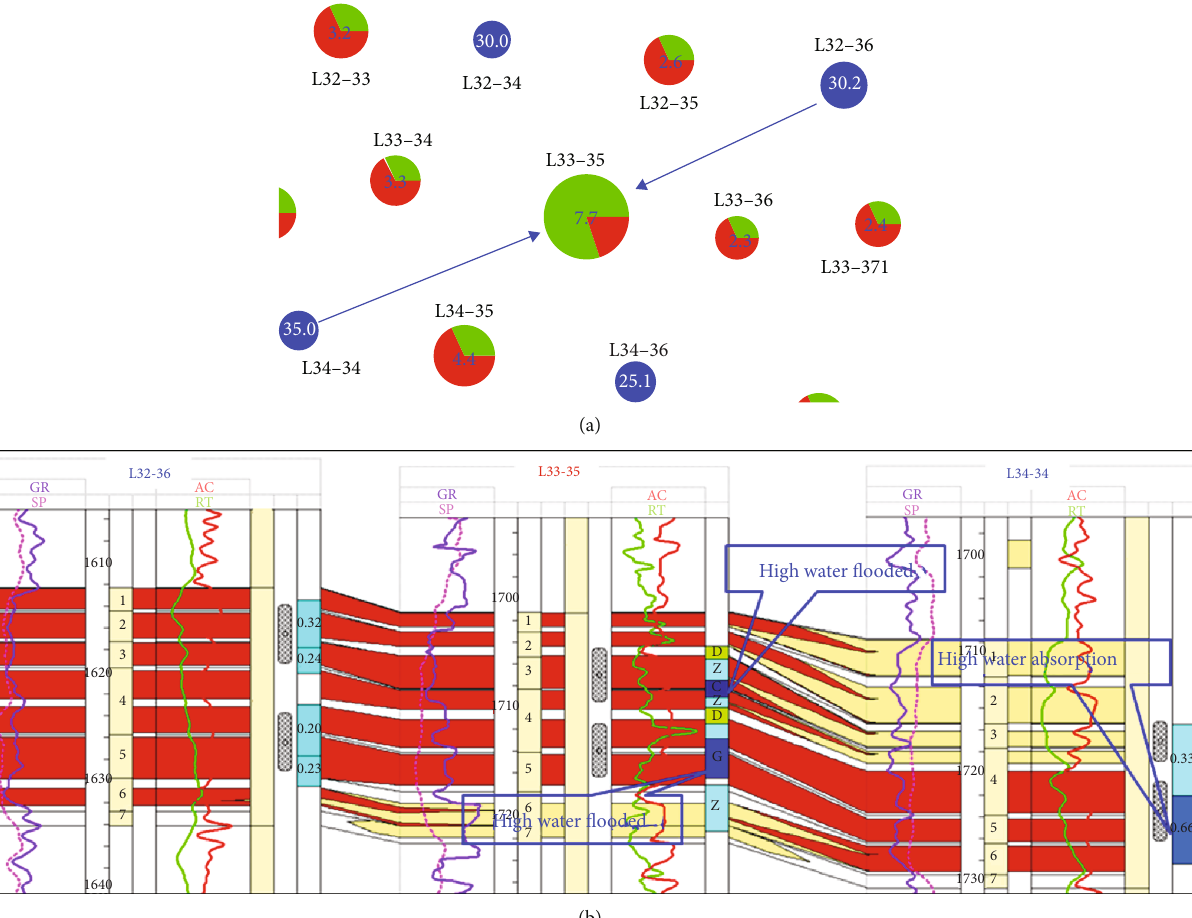
Figure 7: Behavior of production well along the maximum principal stress direction. (a) the pie chart of production of well pattern L33-35 (unit: m 3 /d). (b) the vertical fl ooding extent of L32-36 ~ L33-35 ~